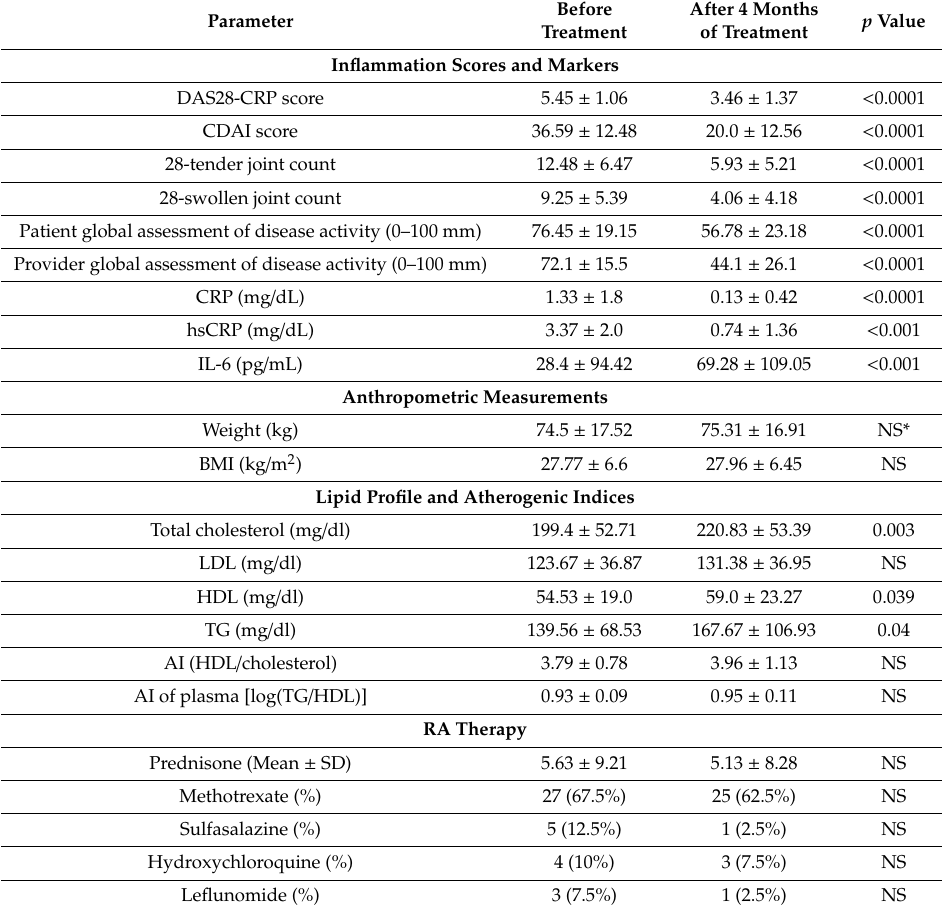
Table 2. E ff ect of tocilizumab (TCZ) on clinical and laboratory